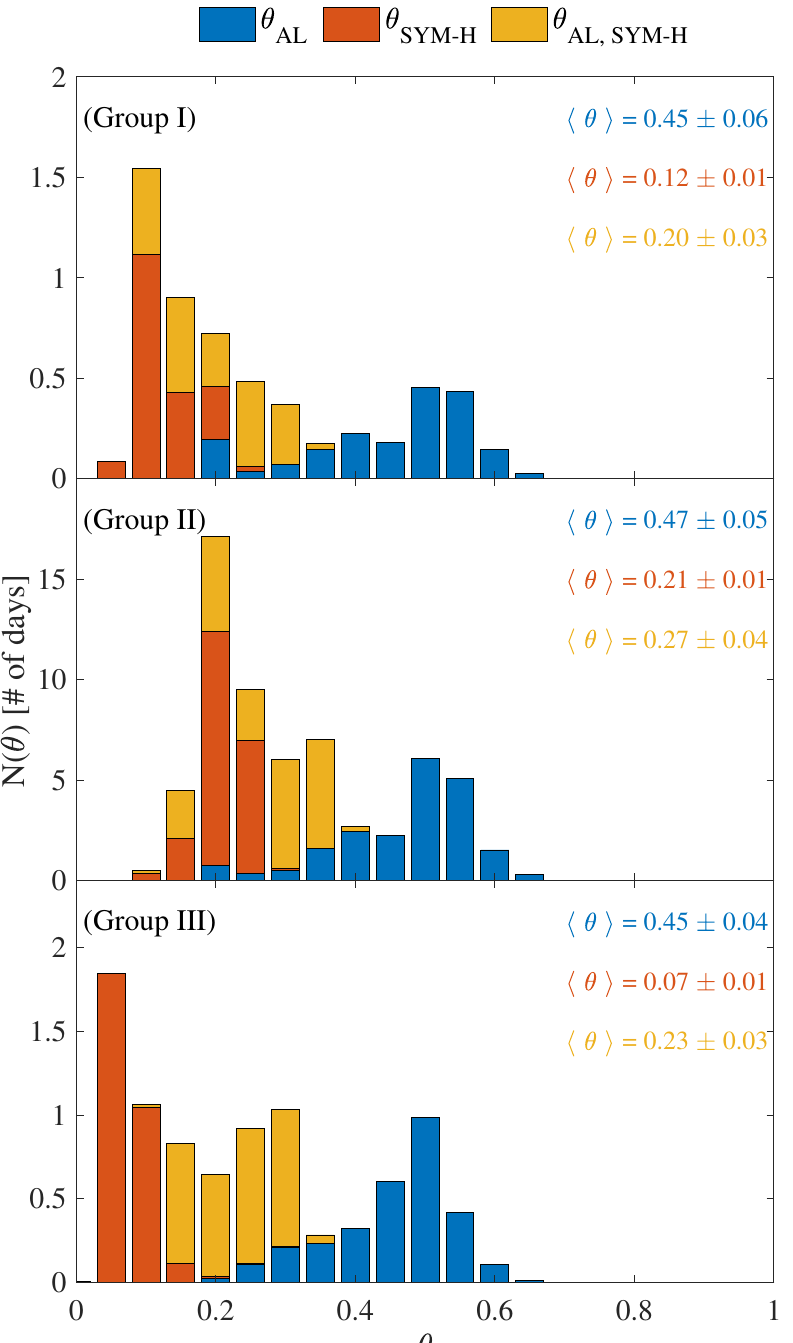
Figure 8. Histograms of the instantaneous stability θ as a function of the different geomagnetic activity levels: Group I (SYM-H > 10 nT), Group II ( − 20 nT ≤ SYM-H ≤ 10 nT), Group III (SYM-H ≤ − 50 nT). Blue, orange, and yellow bars refer to θ AL , θ SYM − H , and θ AL , SYM − H , respectively. The average values and their uncertainties are reported in each panel for each θ . The values of θ have been grouped into equidistant bins of size